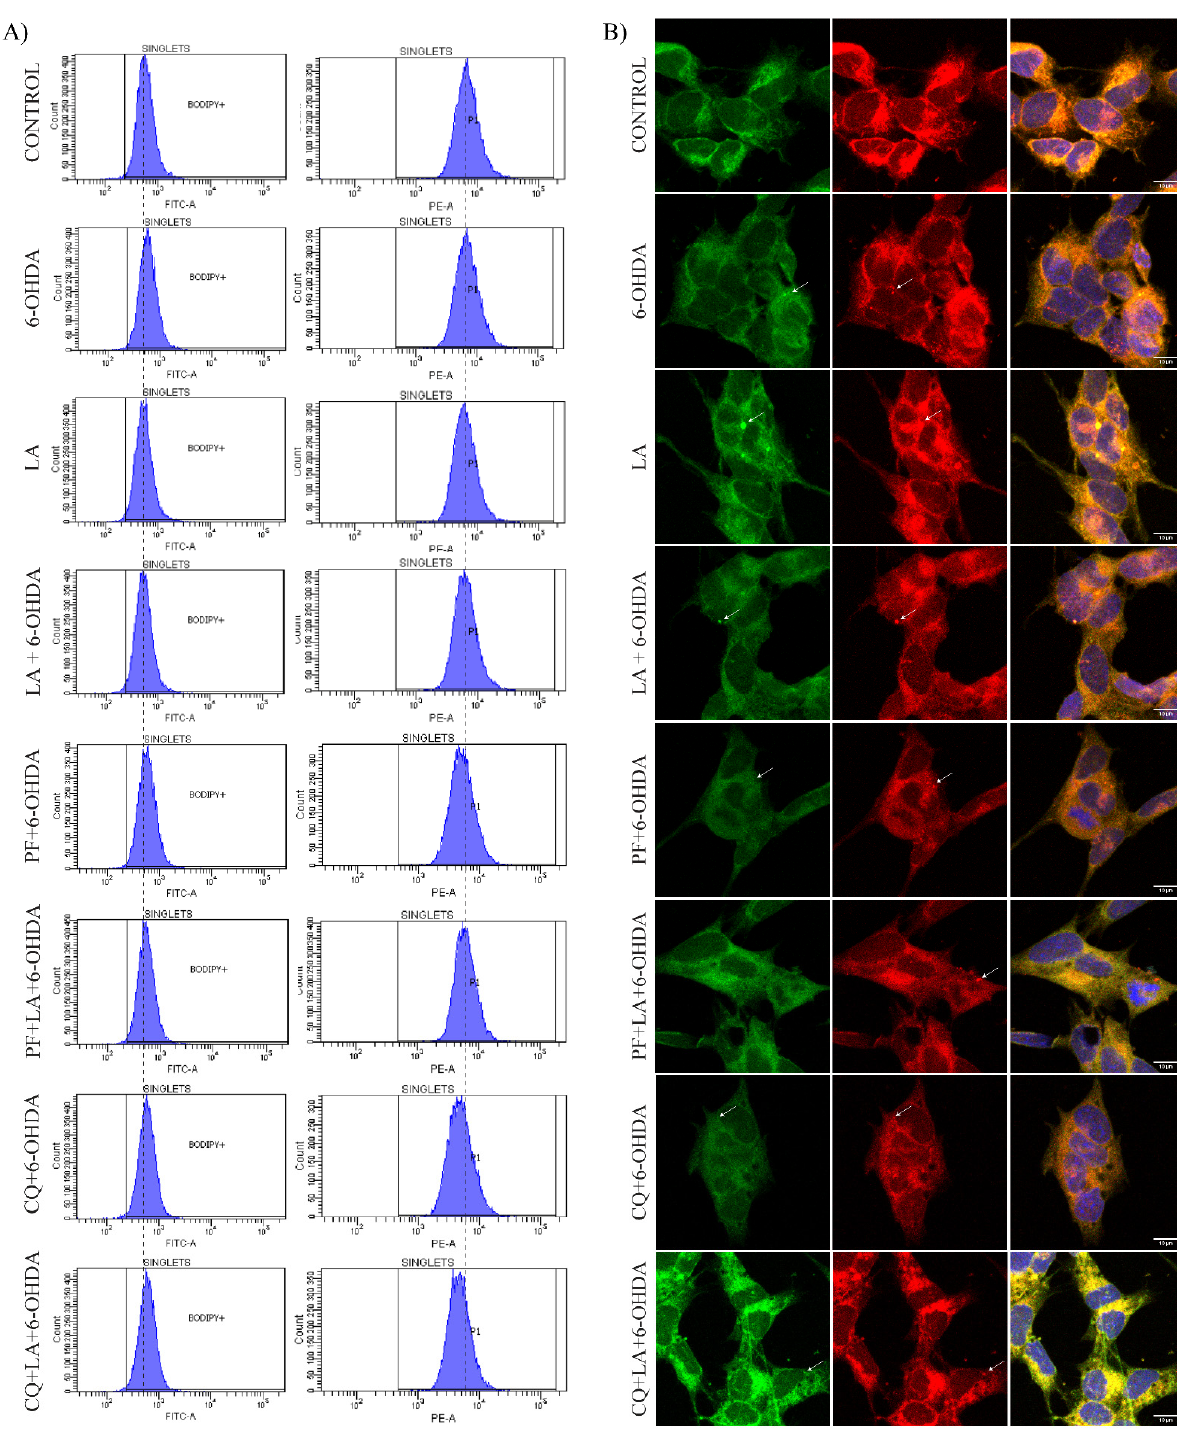
Figure A5. ( A ) BODIPY 581/591 C11 flow cytometry experiments on SH-SY5Y PD model. Representative histograms of flow cytometry experiments with the SH-SY5Y cells marked with BODIPY 581/591 C11 and treated or not with LA, 6-OHDA, PF, and/or CQ. The left column corresponds to the FITC-A signal (peroxidized lipids), and the right column corresponds to the PE-A signal (non-peroxidized lipids). The results correspond to 6 independent experiments per group. ( B ) Representative maximum intensity projection of confocal images showing the immunocytochemical assay with BODIPY 581/591 C11 marker. It shows peroxidized lipids in green and non-peroxidized lipids in red on cells treated or not with LA, PF, CQ, and/or